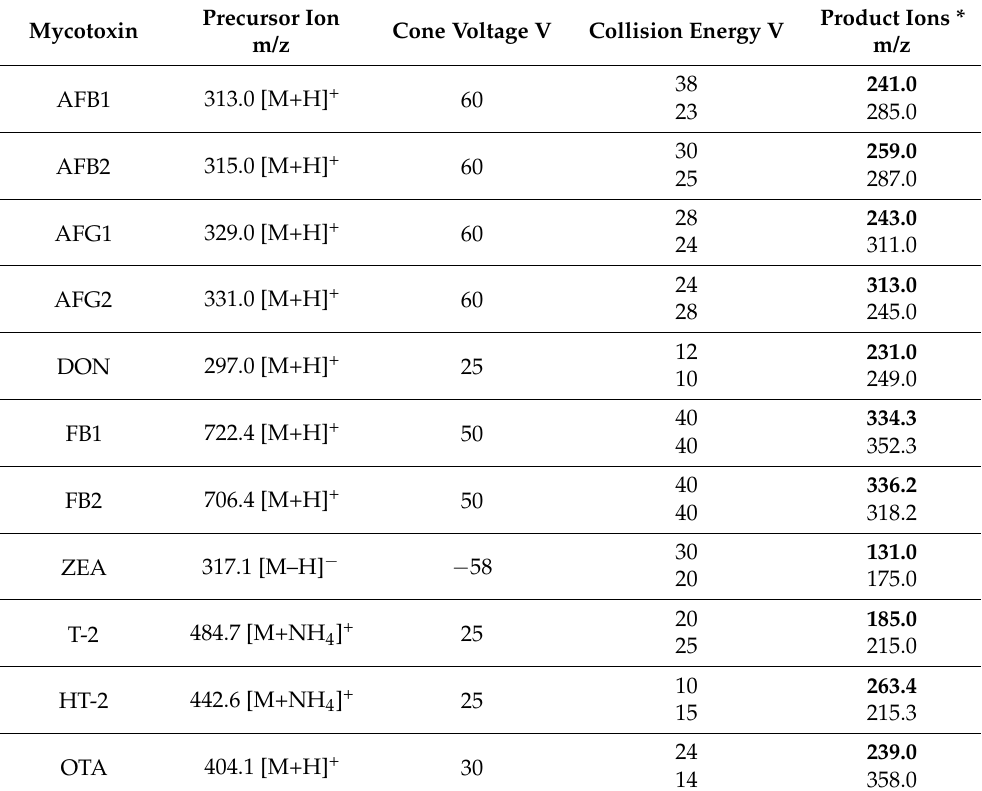
Table 4. MS/MS parameters under optimized